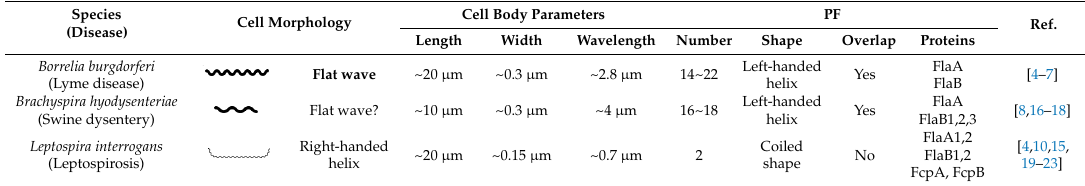
Table 1. Comparison of the cell structure and the periplasmic flagella (PFs) among three spirochete species. Species (Disease)